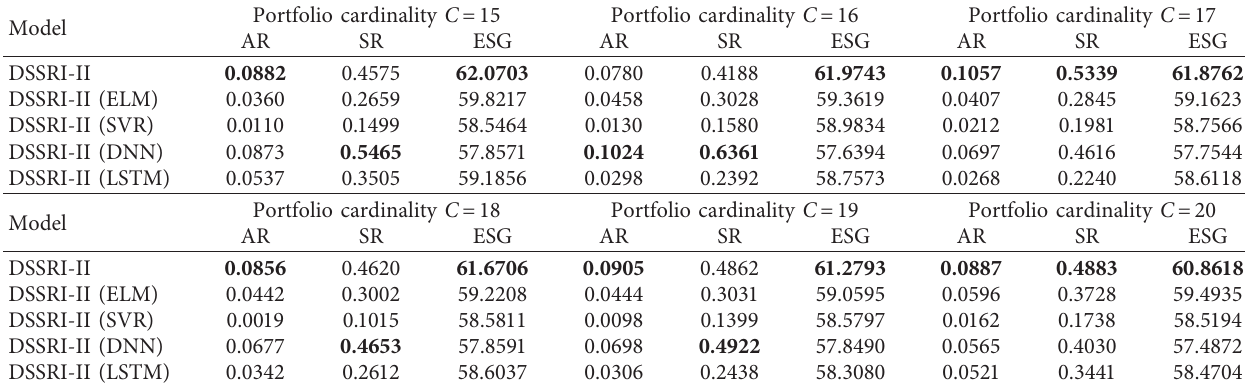
Table 7: Comparison of the DSSRI-II model and the DSSRI-II (based on other machine learning models).